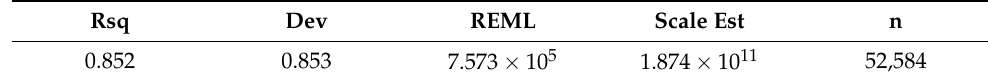
Table 1. Model summary table for non-spatial GAM.